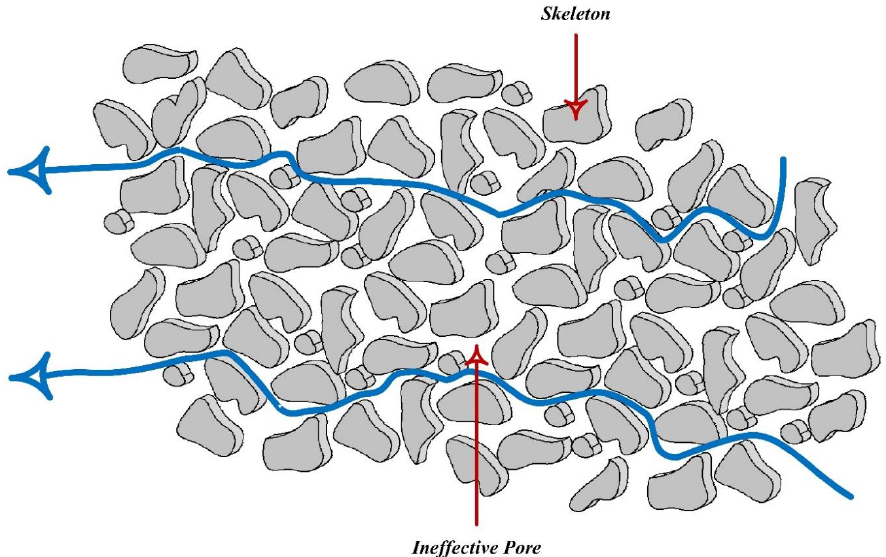
Figure 9. Schematic of a porous medium in which a fluid flows [216].